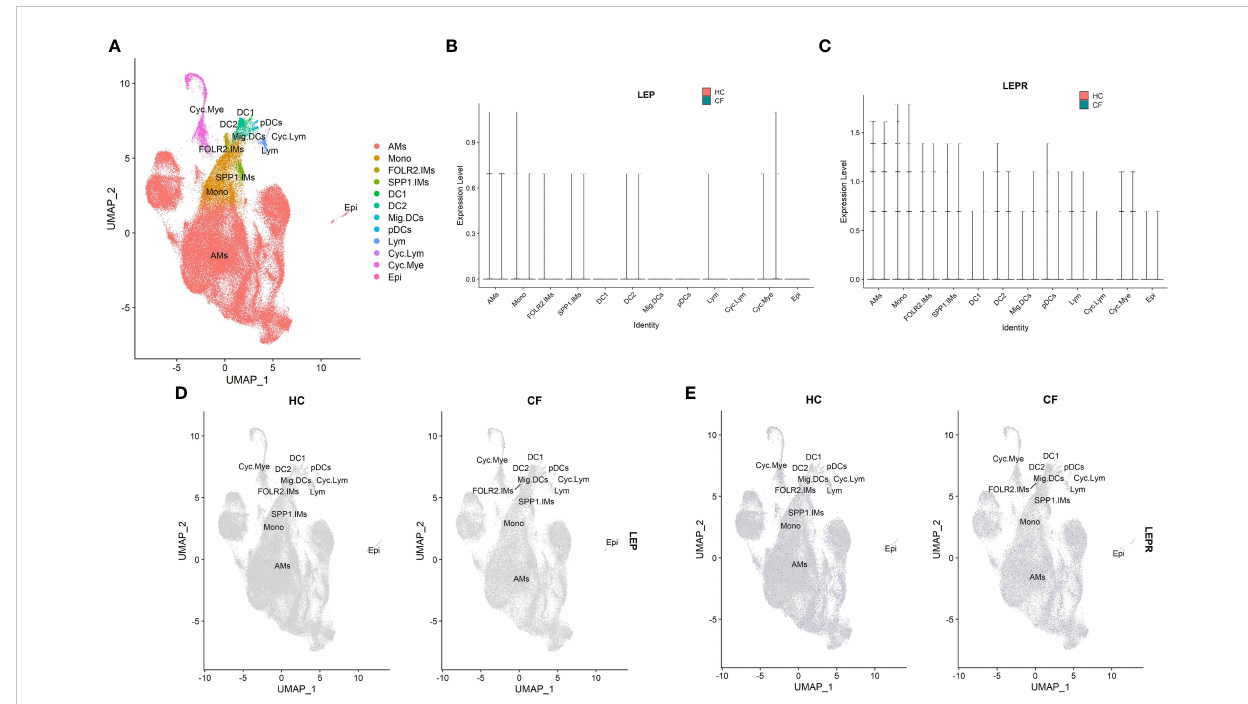
FIGURE 6 The scRNA-seq analysis in the GSE193782(CF = 3, control = 4). (A) Cell type annotation. (B) The expression of LEP mRNA in different cell groups. (C) The expression of LEPR mRNA in different cell groups. (D) Feature plot of LEP mRNA in CF patients and controls. (E) Feature plot of LEPR mRNA in CF patients and controls. The 12 major cell types: AMs, alveolar macrophages; Cyc. Mye, myeloid cycling cells; Cyc. Lym, lymphoid cycling cells; FOLR2.IMs , FOLR2 interstitial macrophages; SPP1.IMs, SPP1 interstitial macrophages; Mono, monocytes; DC1, dendritic cells 1; DC2, dendritic cells 2; Mig. DC, migratory dendritic cells; pDCs, plasmacytoid dendritic cells; Lym, lymphocytes; Epi, epithelial